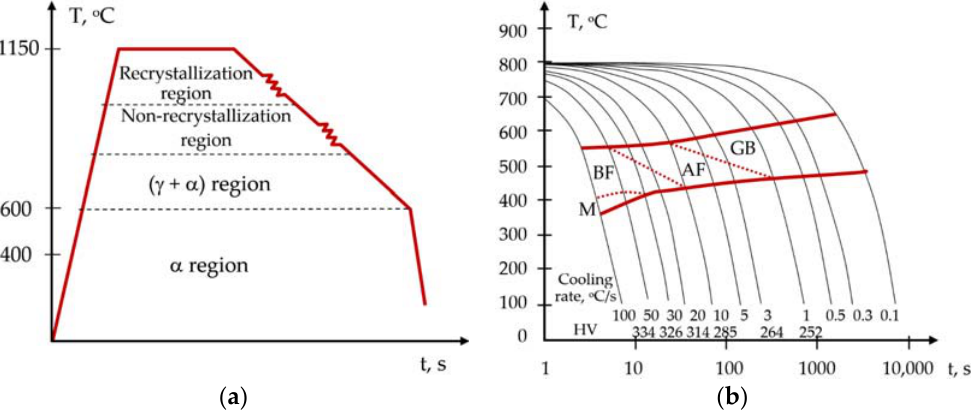
Figure 5. ( a ) TMCP diagram of HSLA steel Data from [11]. ( b ) CCT diagram of HSLA steel. Data from